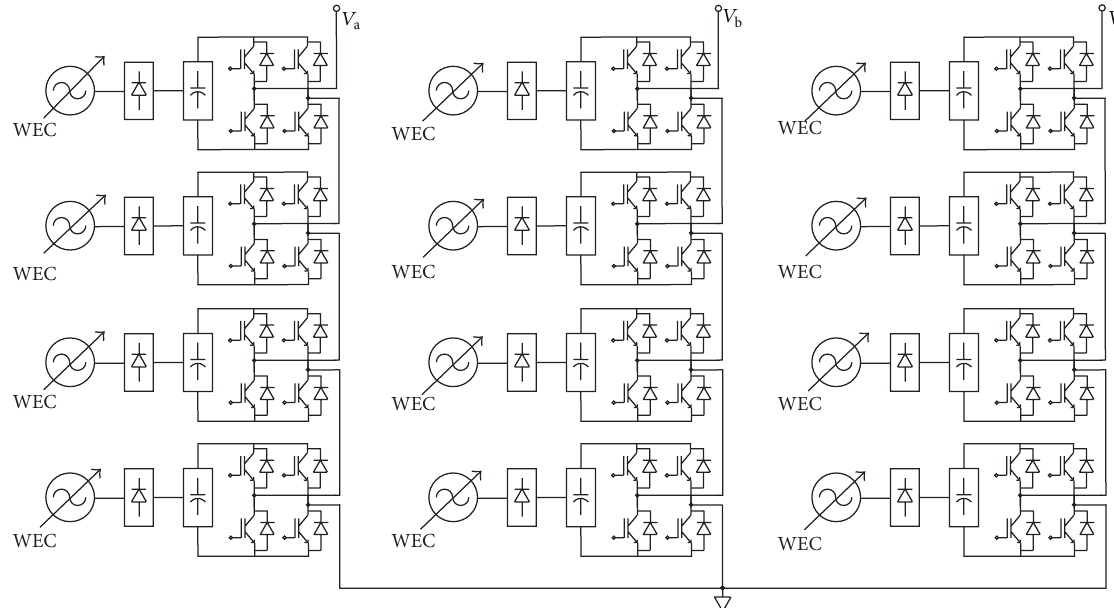
Figure 2: Proposed grid connection topology for a small-scale wave power farm, using the Y-connected 9-level